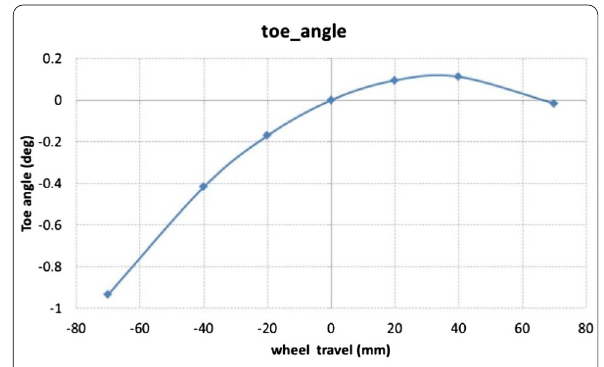
Figure 4 Toe angle change with wheel travel